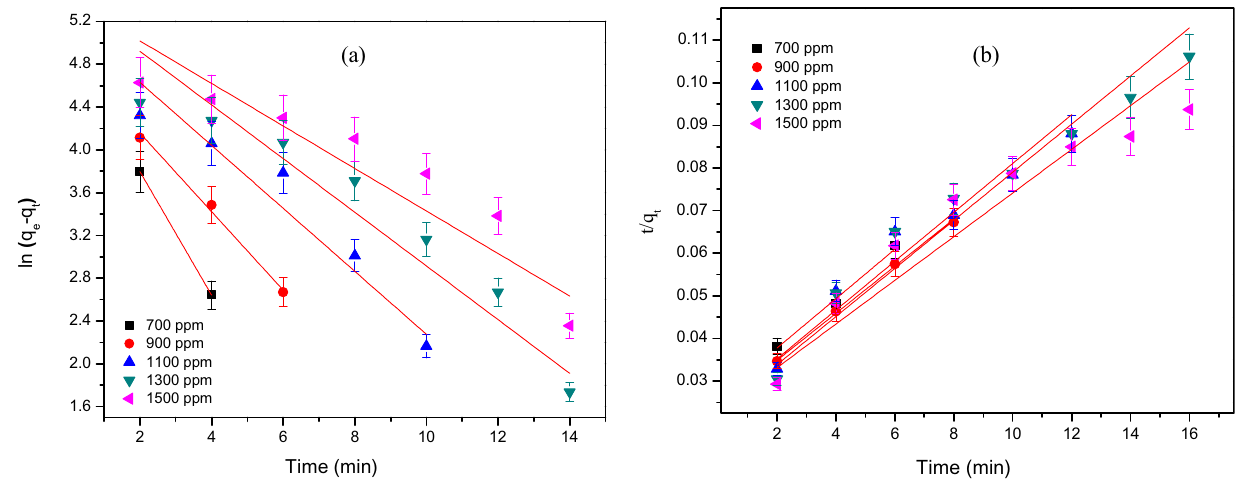
using ( a ) pseudo-first-order and ( b ) pseudo-second-order adsorption models for dif- 3